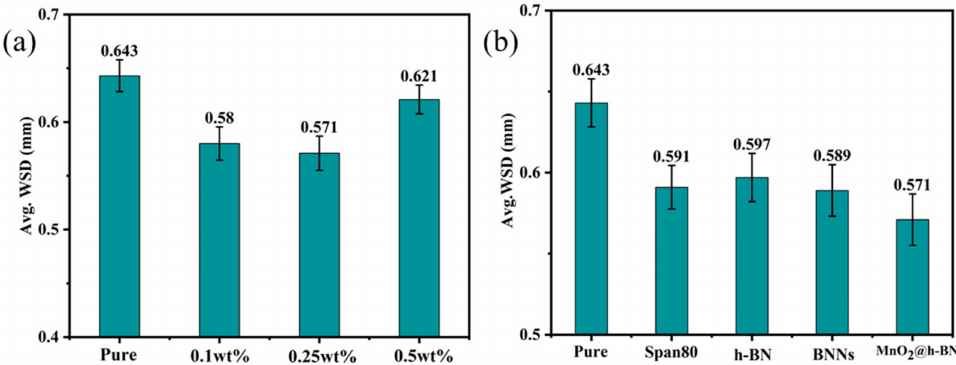
Figure 5. ( a ) WSD of different concentrations of MnO 2 @h-BNNs and ( b ) WSD of different